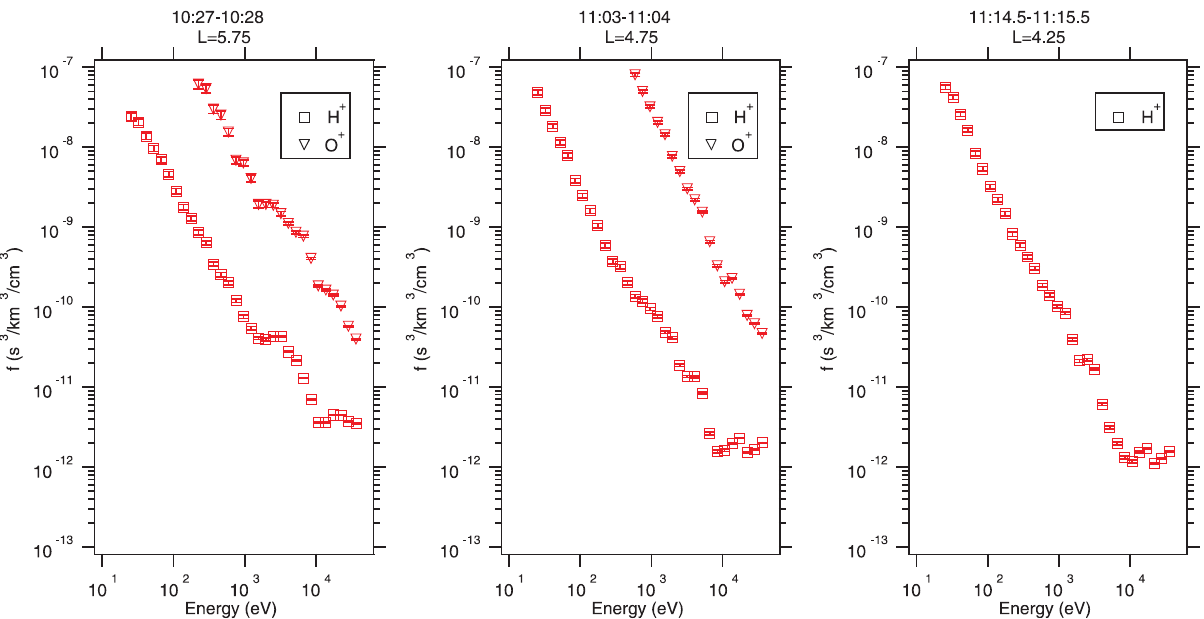
Fig. 4. Ion distribution function versus energy for 1-min time periods at L = 5.75, L = 4.75, and L = 4.25. O + is not shown at L = 4.25 because the low energy range is contaminated by background at this